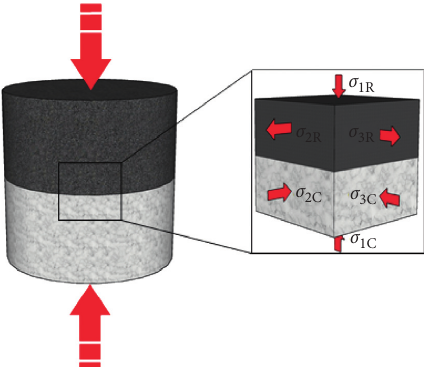
Figure 8: The triaxial stress state in a combined black sandstone- white sandstone sample and its